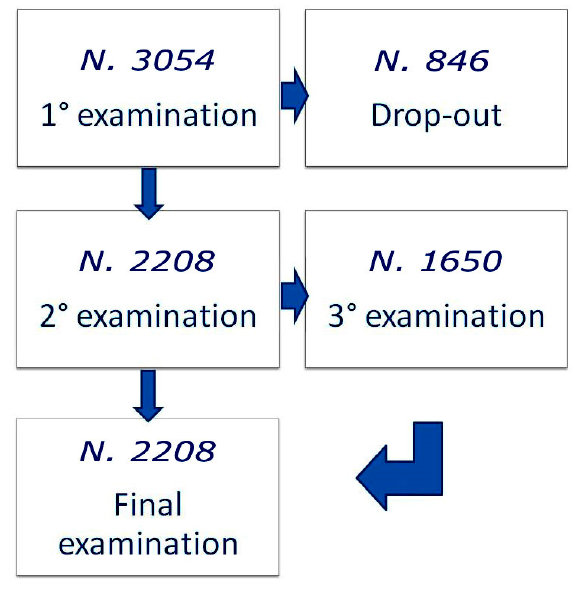
Figure 1. Design of the study .